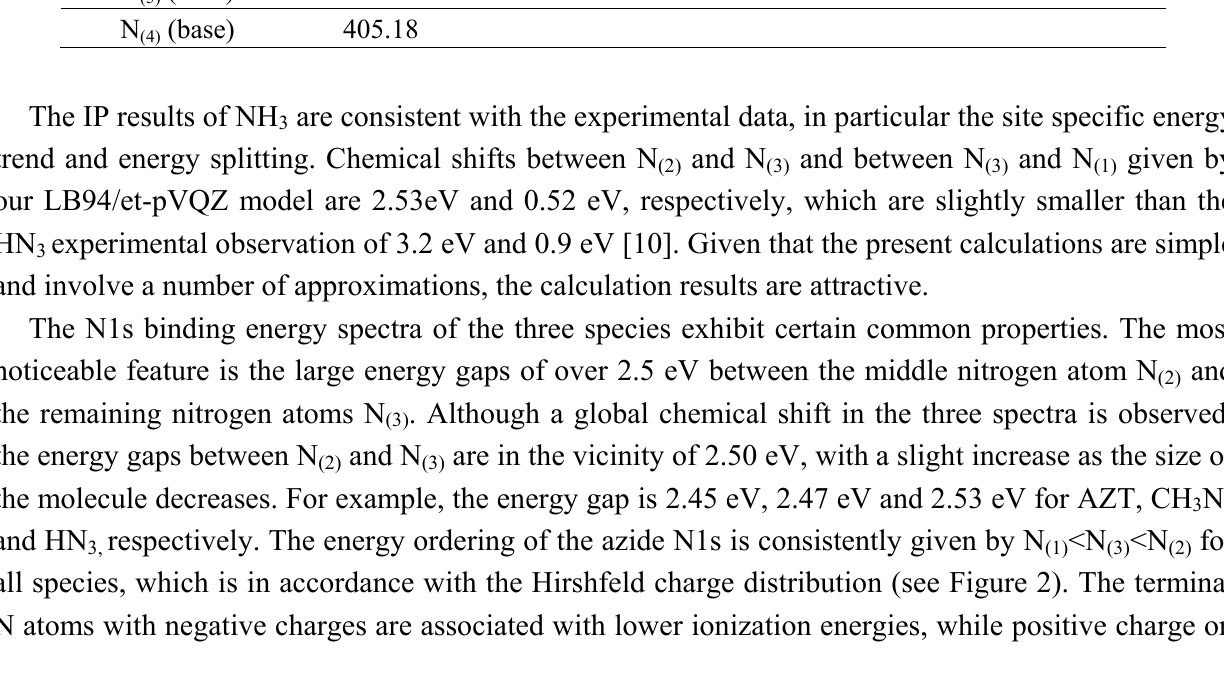
Table 3. Vertical ionization energies of N1s sites in HN